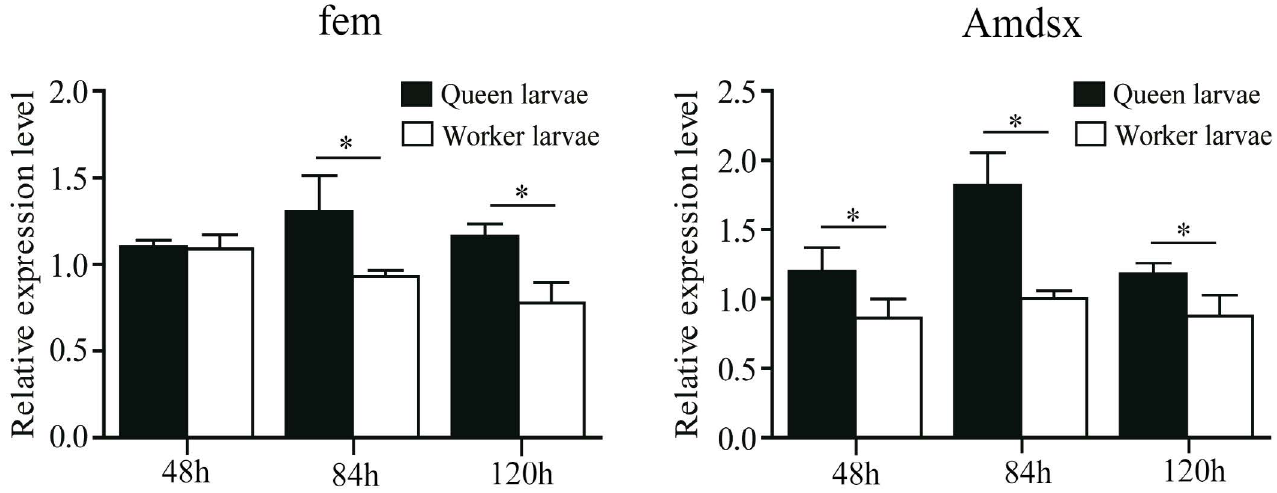
Fig 1 . Expression differences of fem and Amdsx between queen larvae and worker larvae. * represent significant difference (t-test, p<0.05).